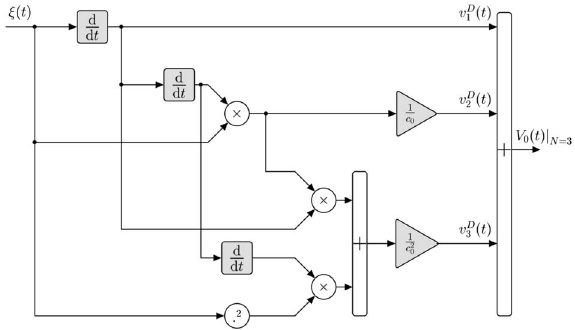
Figure 4. Continuous time realisation structure of D truncated at N = 3, composed of sums and products of the diaphragm displacement and its time derivatives.